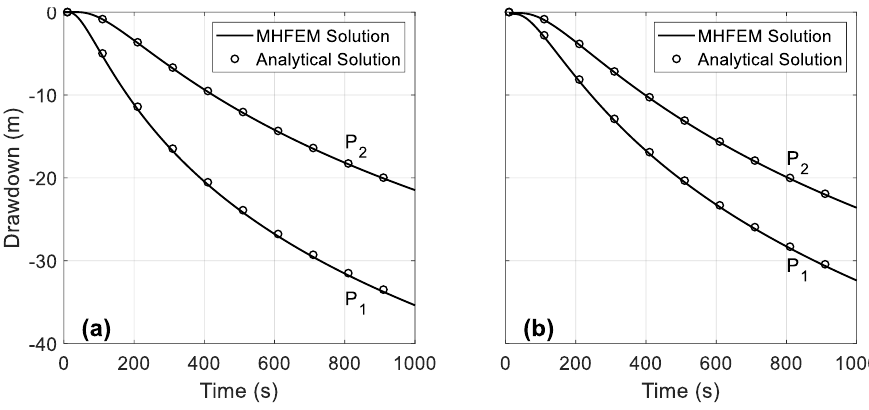
Figure 3. The hydraulic head drawdown in an anisotropic aquifer: comparison of the Papadopulos analytical solution with results of the MHFEM model at piezometers P 1 and P 2 with ( a ) a diagonal transmissivity tensor, and ( b ) a full symmetric transmissivity tensor.